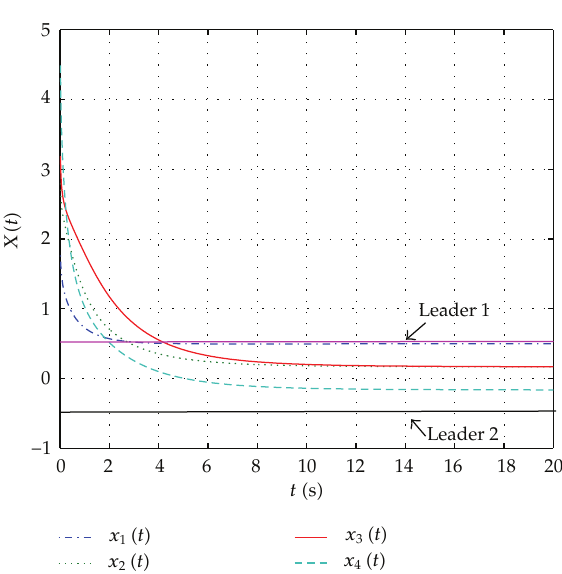
Figure 3: State trajectories of four follower agents and two leaders under the topology G 1